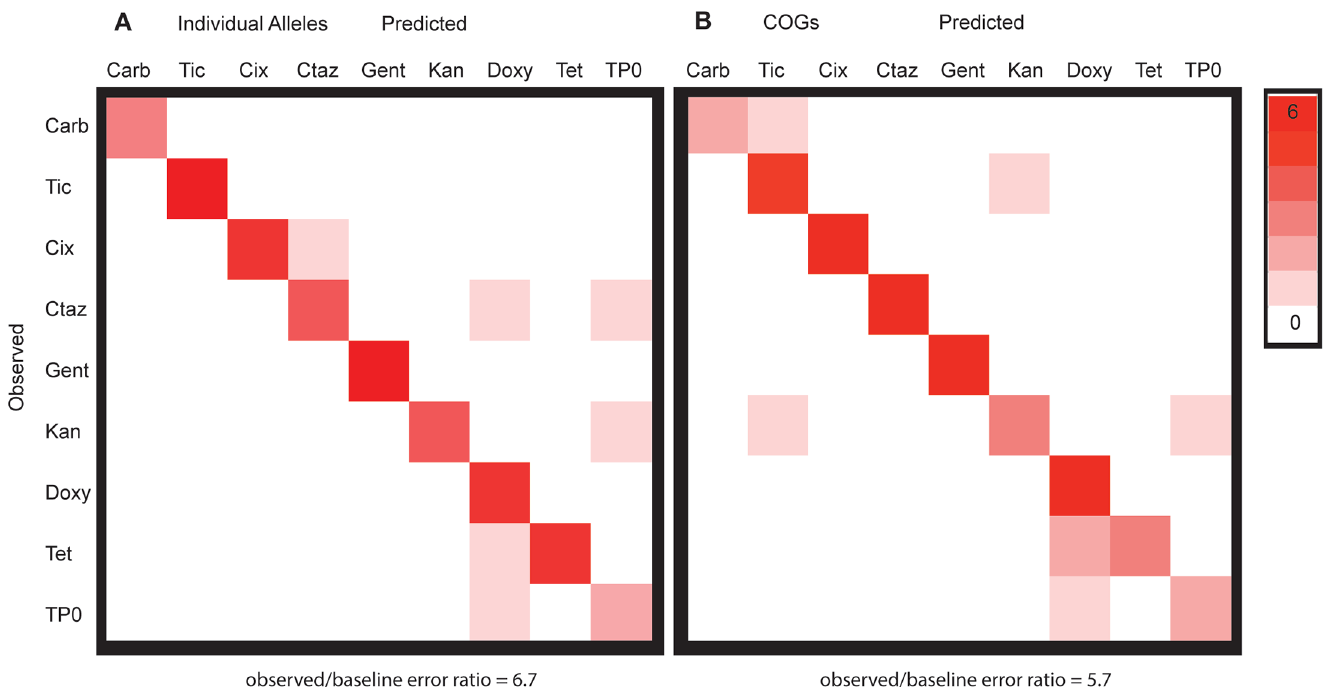
Fig 4. Supervised learning is able to distinguish between the antibiotics at both the allele and COG level. Confusion matrices for random forest classifiers. Off diagonal classification represents classifier error. Antibiotic abbreviations as in Fig